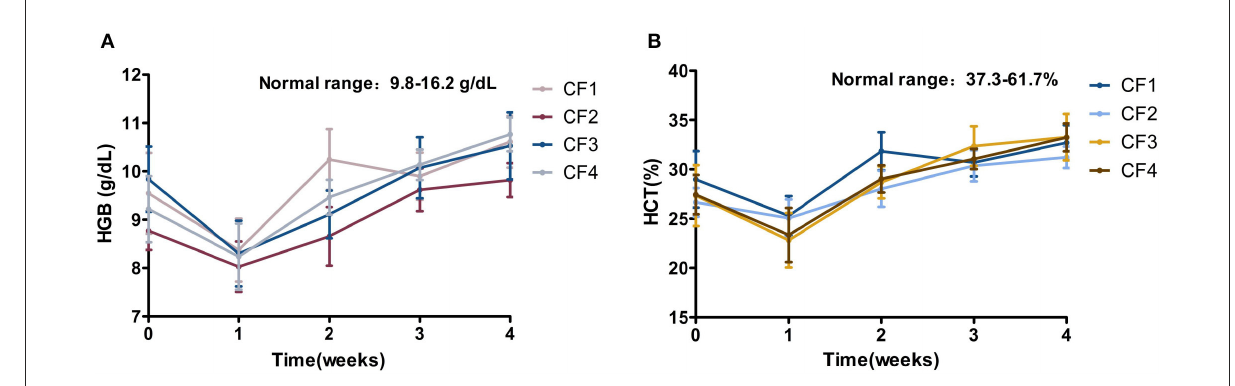
FIGURE5 Mean HGB, HCT variation and standard error for 4 groups cats that completed 4 weeks of treatment. (A) HGB. (B) HCT. HGB, hemoglobin; HCT, hematocrit.